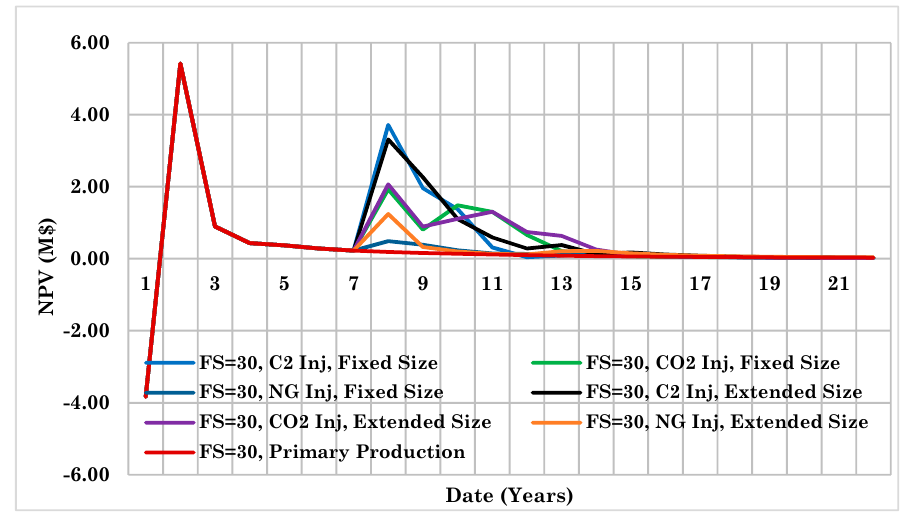
Figure 22. NPV of the scenarios for fixed and extended cycles of cyclic CO2, C2 and NG injection as well as natural depletion, FS = 30, Oil API = 38.